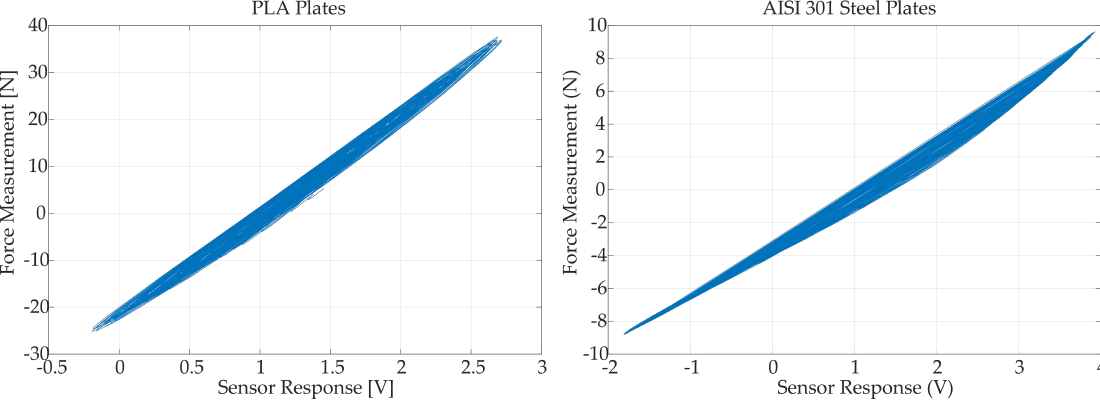
Figure 10. Sensor voltage output compared to the force measured in the commercial load cell, for both tested configurations. The shown graphs are the result of overlapping all the load–unload curves applied during the calibration process, revealing the shape of the hysteresis cycle for each